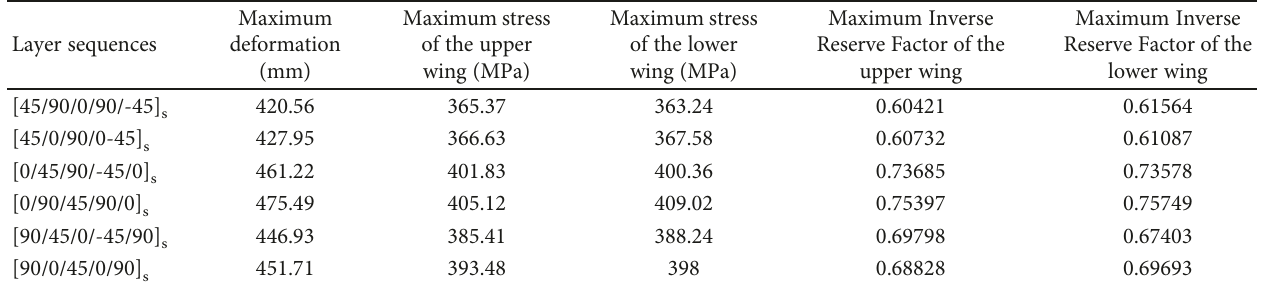
Table 6: Structural performance under di ff erent layup sequences.